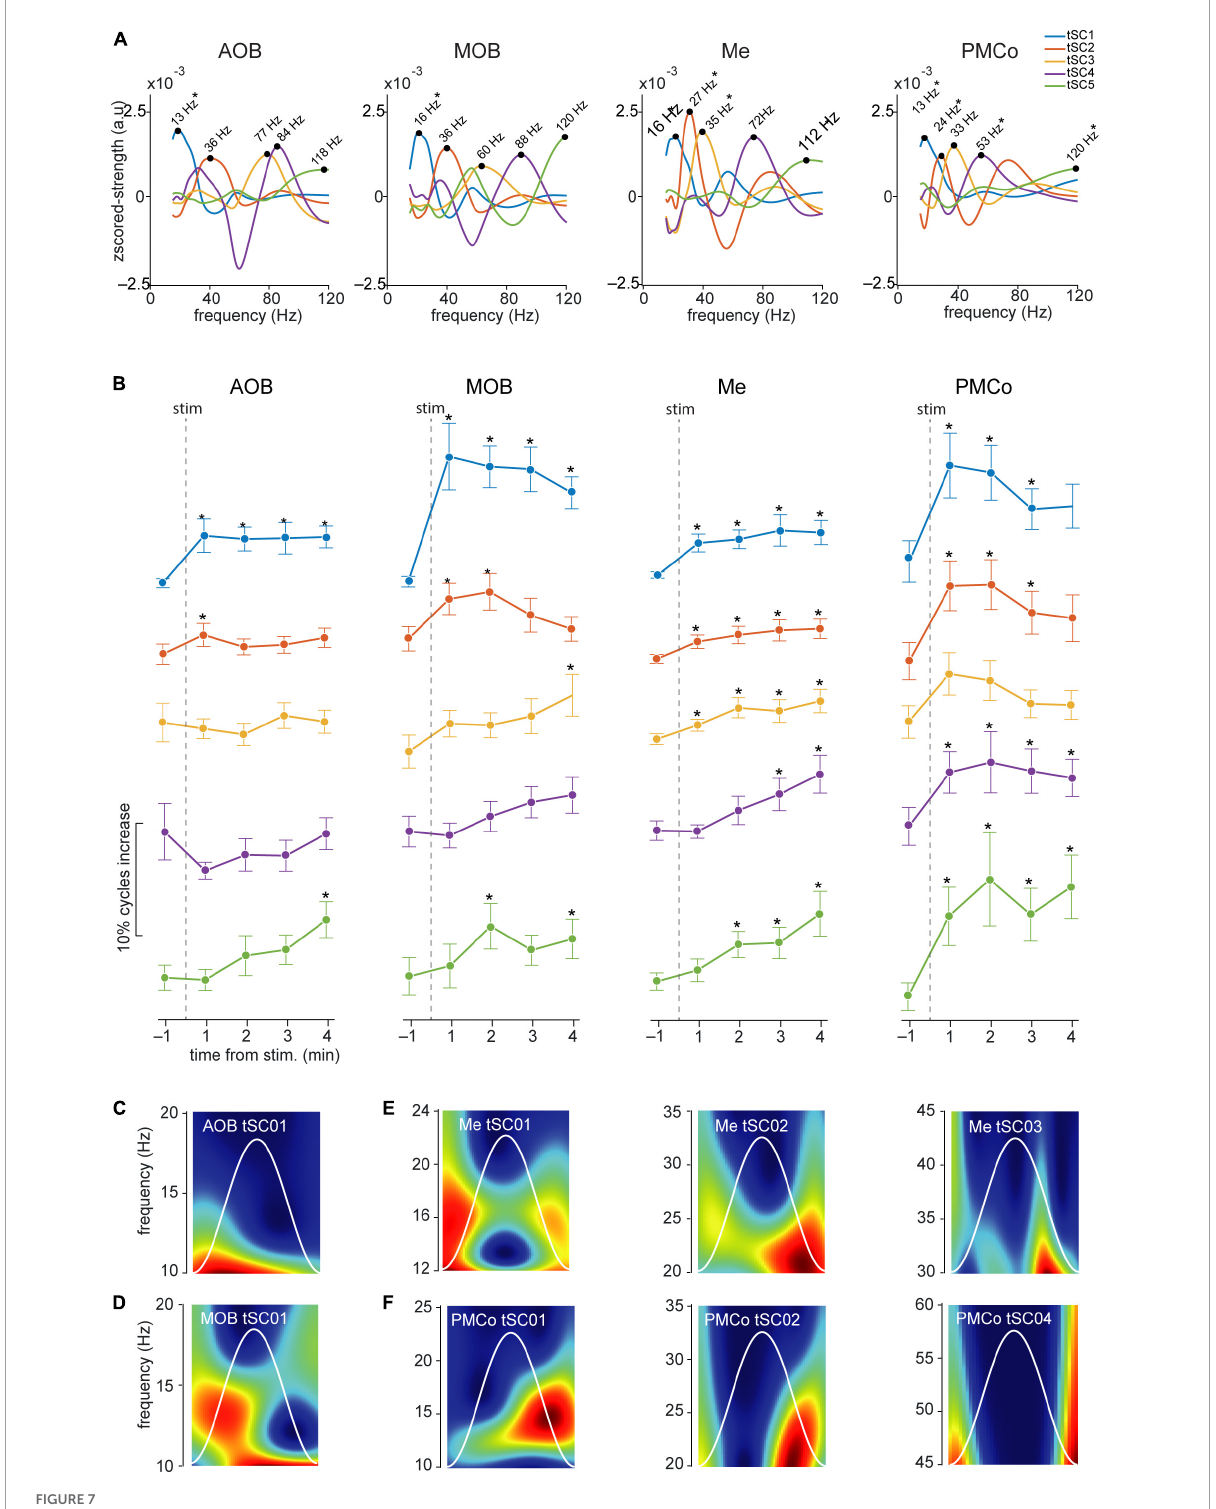
FIGURE7 Temporal analysis of the theta cycles and evoked tSCs for conspecific stimuli. (A) Spectral signatures in the frequency domain of the analyzed tSCs, for the four brain regions during the exploration of conspecific-derived stimuli. Asterisks indicate those tSCs that showed a significant increase from the control period. (B) Proportion of theta cycles with nested components per minute of the five tSC, before and after the conspecific stimuli presentation * p < 0.05 compared to pre-stimulus value. (C) Representative wavelet spectrogram of tSC1 in AOB; (D) tSC1 in MOB; (E) tSC1, tSC2, and tSC3 in Me; (F) tSC1, tSC2, and tSC4 in